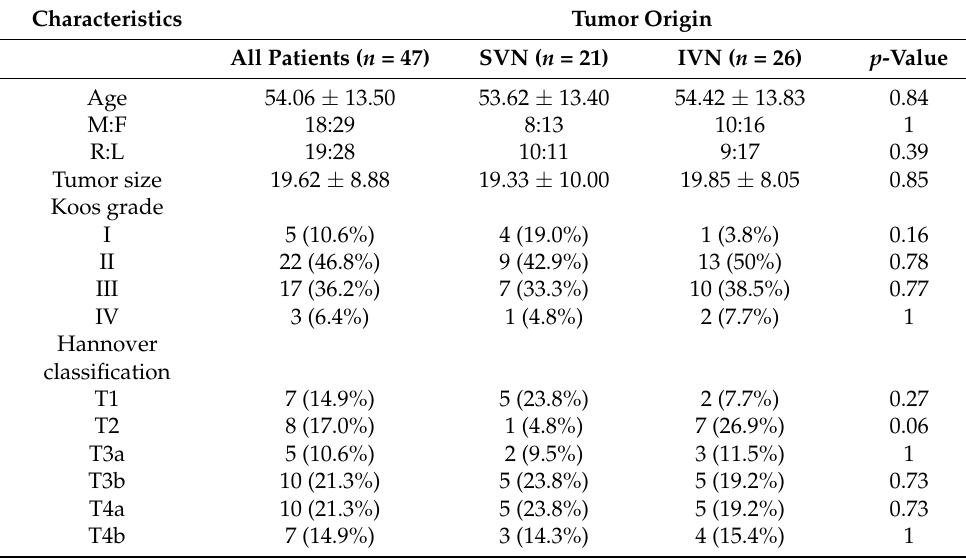
Table 1. Patient demographics and tumor